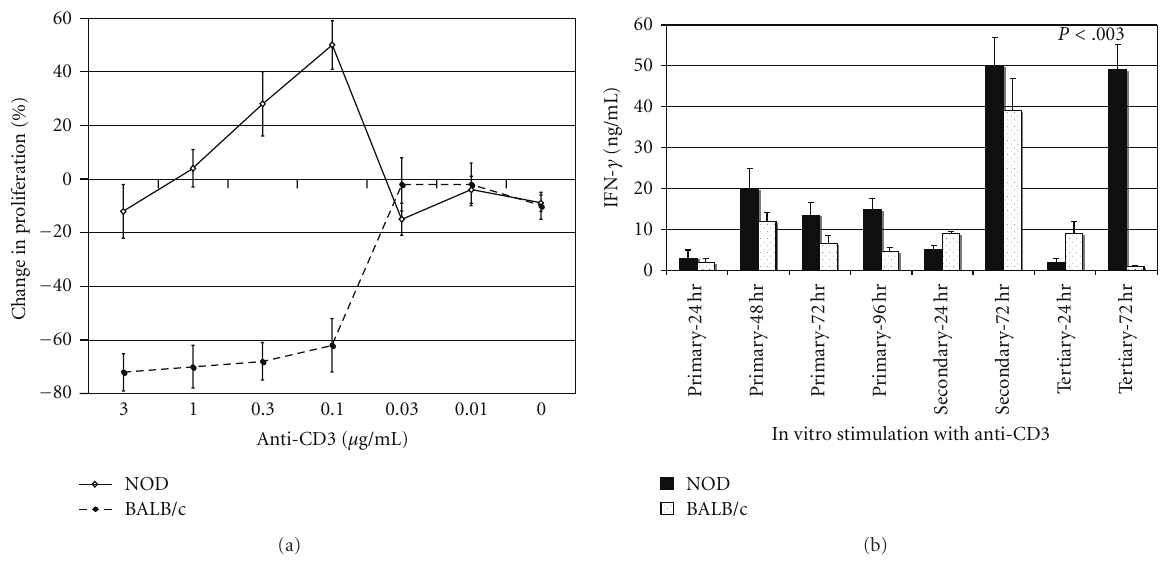
Figure 1: (a) Secondary NOD T cell blasts are resistant to AICD upon tertiary restimulation. NOD or BALB/c Con A blasts were restimulated on anti-CD3-coated plates, washed, and cultured in IL-2-containing medium for 3 days then stimulated again on anti-CD3-coated plates (0.003–3.0 μ g/mL; 50 μ l/well). Tritium-labeled thymidine was added for the last 16hrs of a 72-hour culture. The data are expressed as percent change versus control wells [(mean cpm anti-CD3 wells/mean cpm IgG wells) × 100]. The standard deviation of triplicate wells was less than 10%, and the results are representative of four experiments. (b) Culture supernatants were collected at various times (24–96 hrs) following primary stimulation (Con A) of NOD or BALB/c spleen cells or secondary and tertiary stimulations of T cells blasts with plate-bound anti- CD3 (1.0 μ g/mL). IFN- γ levels were measured by ELISA, and the results are expressed as ng/mL. The results represent the mean and SD of triplicate wells and are representative of 3 independent experiments. Only P -values that are < .05 are shown.